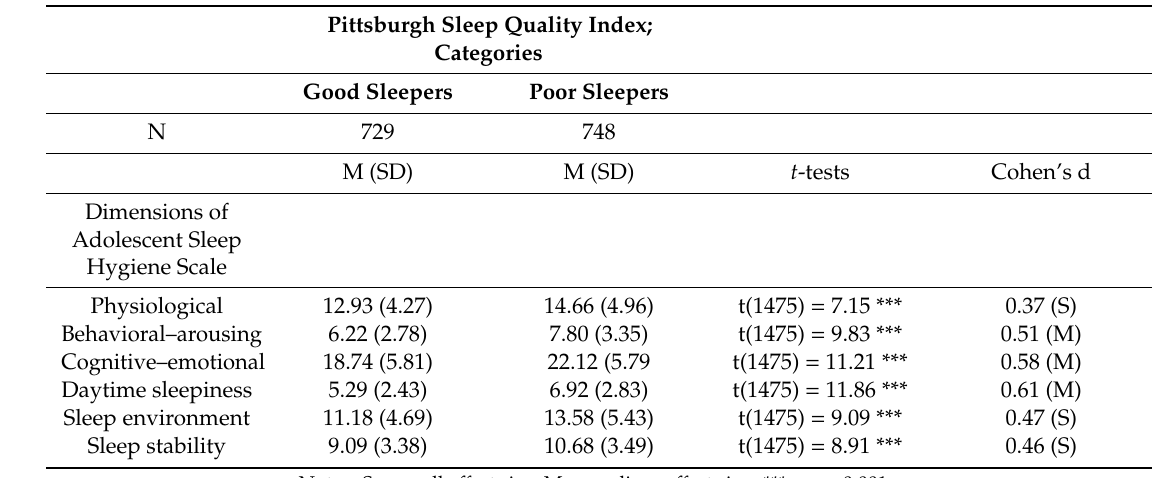
Table 4. Descriptive and inferential statistical indices of the dimensions of the Adolescent Sleep Hygiene Scale (ASHS), separately for good sleepers (n = 729) and poor sleepers (n =